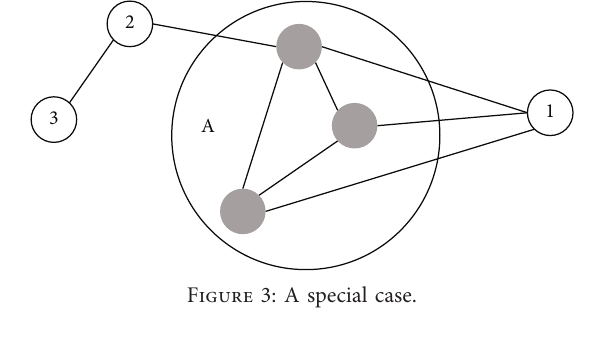
Figure 3: A special case.